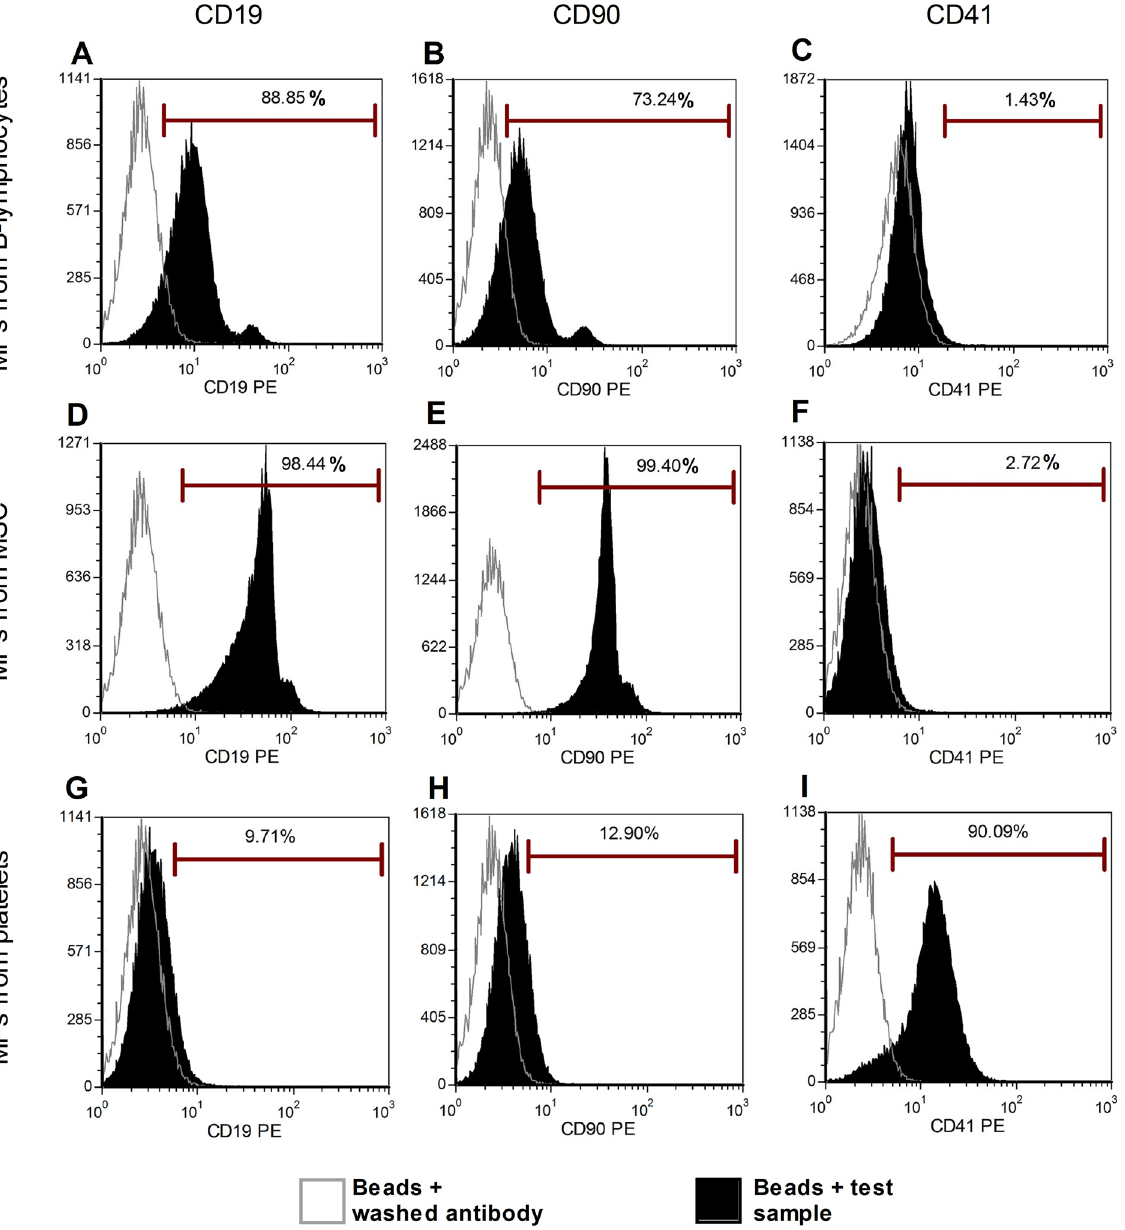
Fig 4. MP characterization by latex bead technique. We studied three types of cell-derived MPs with the latex bead technique: platelet-, BM-MSC- and B- cell-derived MPs. Beads with ‘‘ washing antibody ” were used as negative controls. Three different labels were applied to these MPs. (I) We confirmed the expression of CD41 on platelet-derived MPs, (G-H) and negative signal for CD90 and CD19. (C/F) Although CD41 expression was negative for B-cell and BM-MSC-derived MPs, (A-B, D-E) we observed CD90 and CD19 expression on both B-cells and BM-MSC-derived MPs, confirming false positive